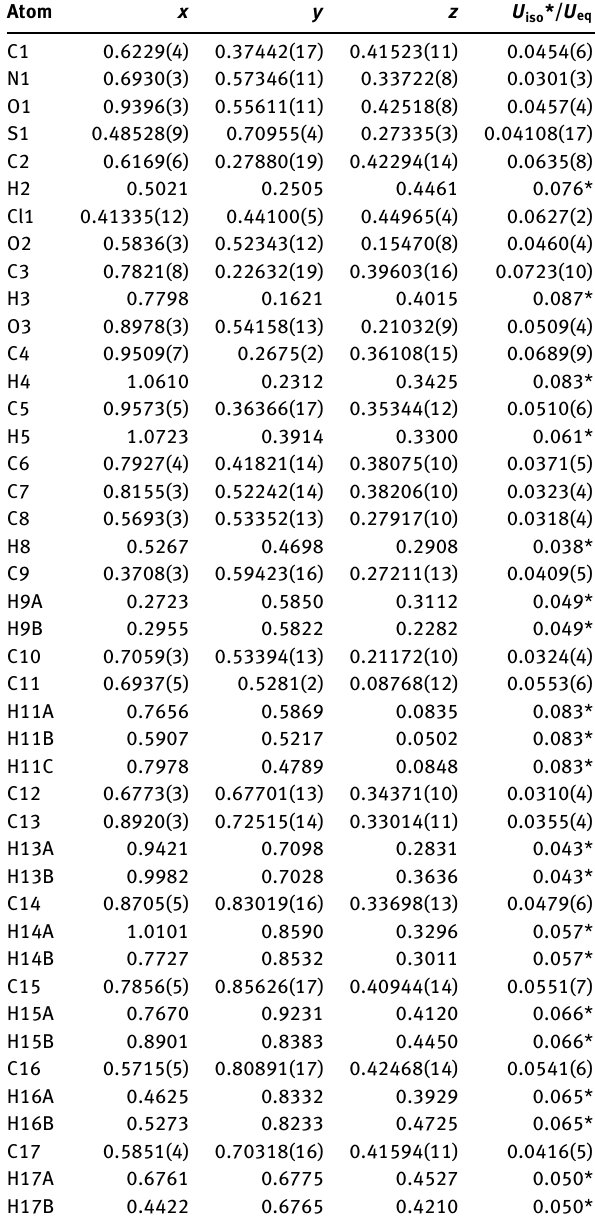
Table 2: Fractional atomic coordinates and isotropic or equivalent isotropic displacement parameters (Å 2